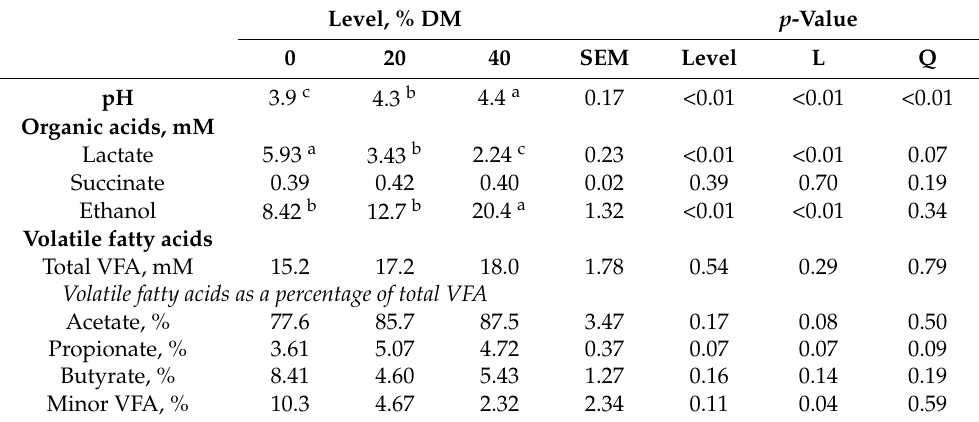
Table 2. Silage pH, percentages, and concentrations of volatile fatty acids (VFA) in sorghum-vegetable mixture silages at day 101 containing 0, 20, or 40% vegetable mixture on a dry matter